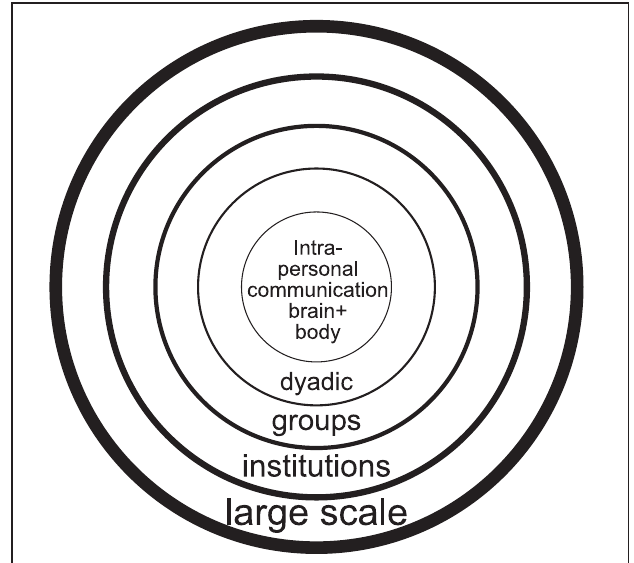
FIGURE 1 | “Onion layer” model suggesting emotions occurring at multiple nested levels. However, while the image suggests a clean hierarchical structure, in reality non-adjacent layers interact in complex ways in the generation (and regulation) of affective processes. Thus a “messy layer” model would be more appropriate as is argued later in the